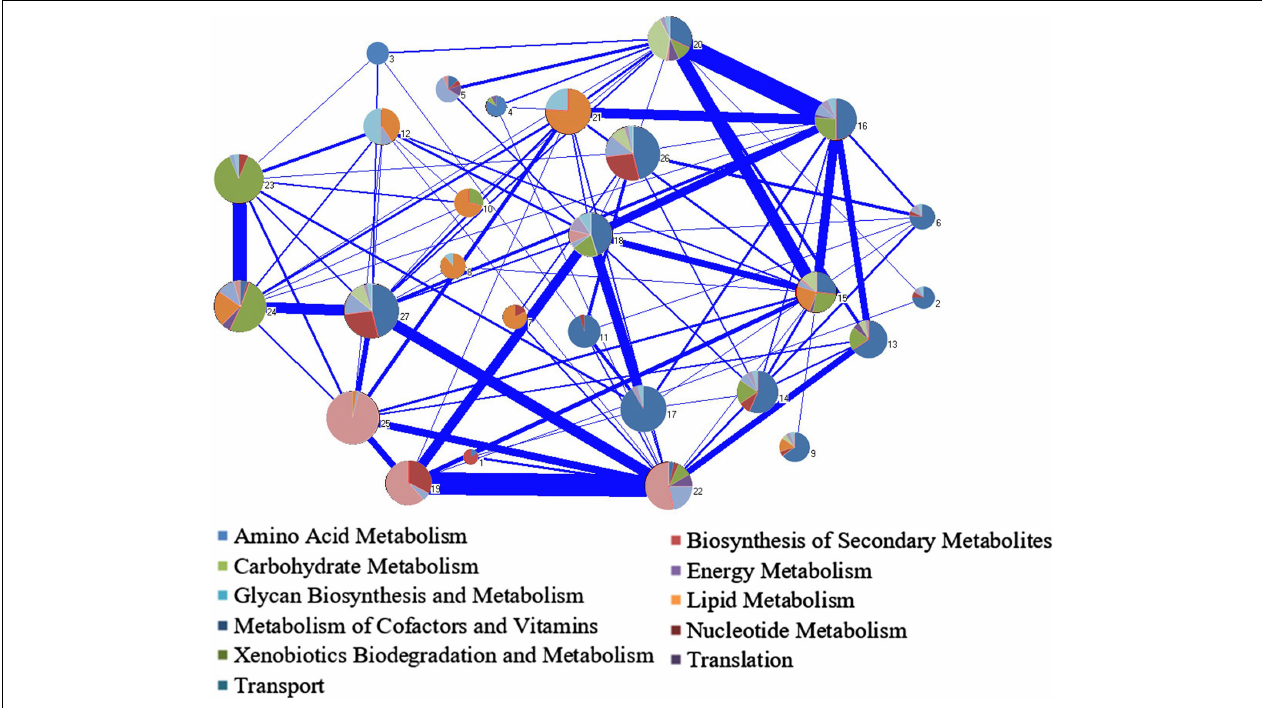
FIGURE 6 | Module decomposition of the biggest weakly connected component (WCC) in Y-organ genome-scale metabolic network (GSMN). Each pie chart represents a single module and contains several different subsystems. The area of a color shows the percentage of the subsystem it represents in the pie chart. The width of the line between the modules represents the strength of connection.